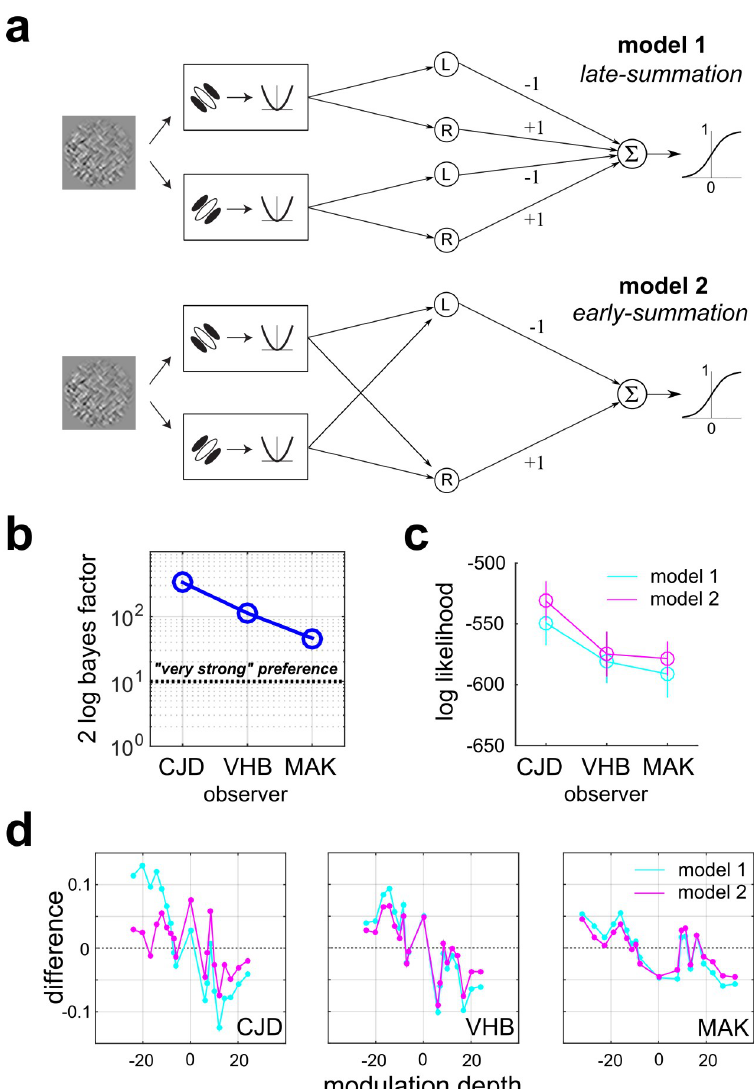
Fig 12. Model comparison for Experiment 3, boundary orientation identification with textures composed of two kinds of micropatterns. (a) Two competing models of FRF architecture fit to psychophysical trial data. Top : Model 1 (“late summation”) assumes that each first-stage orientation channel is analyzed by its own pair of (L/R) second-stage filters and then pooled. Bottom : Model 2 (“early summation”) assumes that each (L/R) second-stage filter integrates over both first-stage channels. ( b ) Bayesian model comparison making use of all data reveals a strong consistent preference (as measured by the Bayes factor—see text) for Model 2 (“early summation”) for all three observers (blue line and symbols). Thick black line indicates the conventional criterion for a “very strong” preference for Model 2. ( c ) Bootstrapping analysis, in which model likelihood is evaluated on novel data not used for model training, also reveals a preference for Model 2. Plotted points indicate mean +/- SEM for 50 bootstrapped samples. ( d ) Difference between predicted and observed proportions where observer chooses “right oblique” for all observers and both models. Negative modulation depths indicate left-oblique